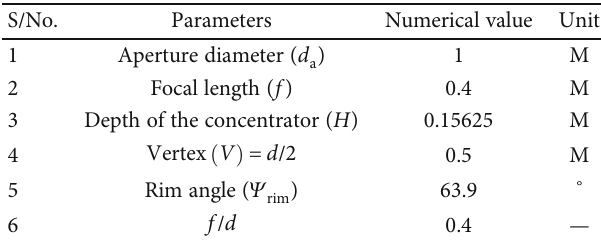
Table 1: Design parameters of the solar parabolic dish